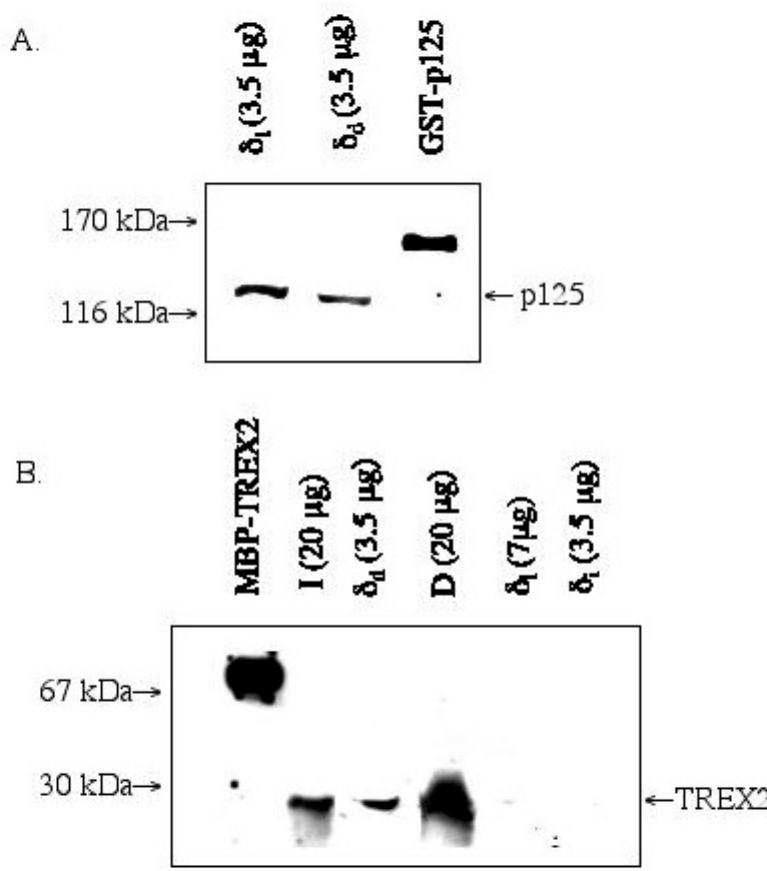
FIGURE 1. The TREX2 3 ′→ 5 ′ exonuclease copurifies with pol δ d . A: Western blot analysis of calf thymus pol δ i and δ d with polyclonal antibody against C-terminal part of catalytical subunit of pol δ (p125). B: Isotonic (I), detergent (D) calf thymus extracts pol δ i and pol δ d were loaded on 8% SDS-PAGE and transferred on nitrocellulose membrane. Polyclonal chicken antibody against TREX2 recognizes TREX2 exonuclease in both extracts and pol δ d